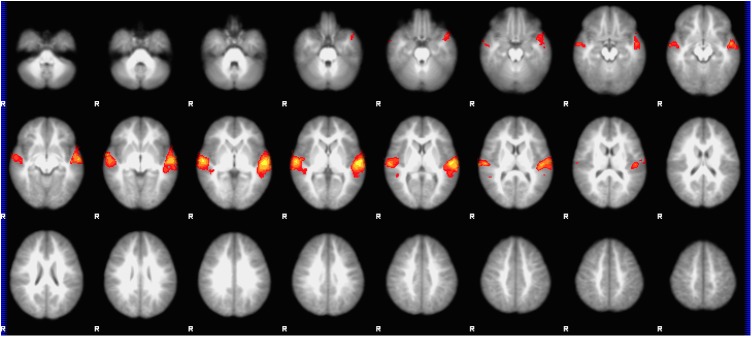
Group mean activation map for the story listening task.Group mean BOLD fMRI activation map for our story listening task (stories>tones) in 4 year-old girls (n = 22). All voxels significant at p<0.05 (FDR corrected), slice thickness 5 mm for contiguous slices. Slices range from z = -28 to z = 74 in MNI coordinate space. Color scale ranges from t = 1.25 (cooler) to 4 (hotter). Radiological orientation, left = right, right = left.